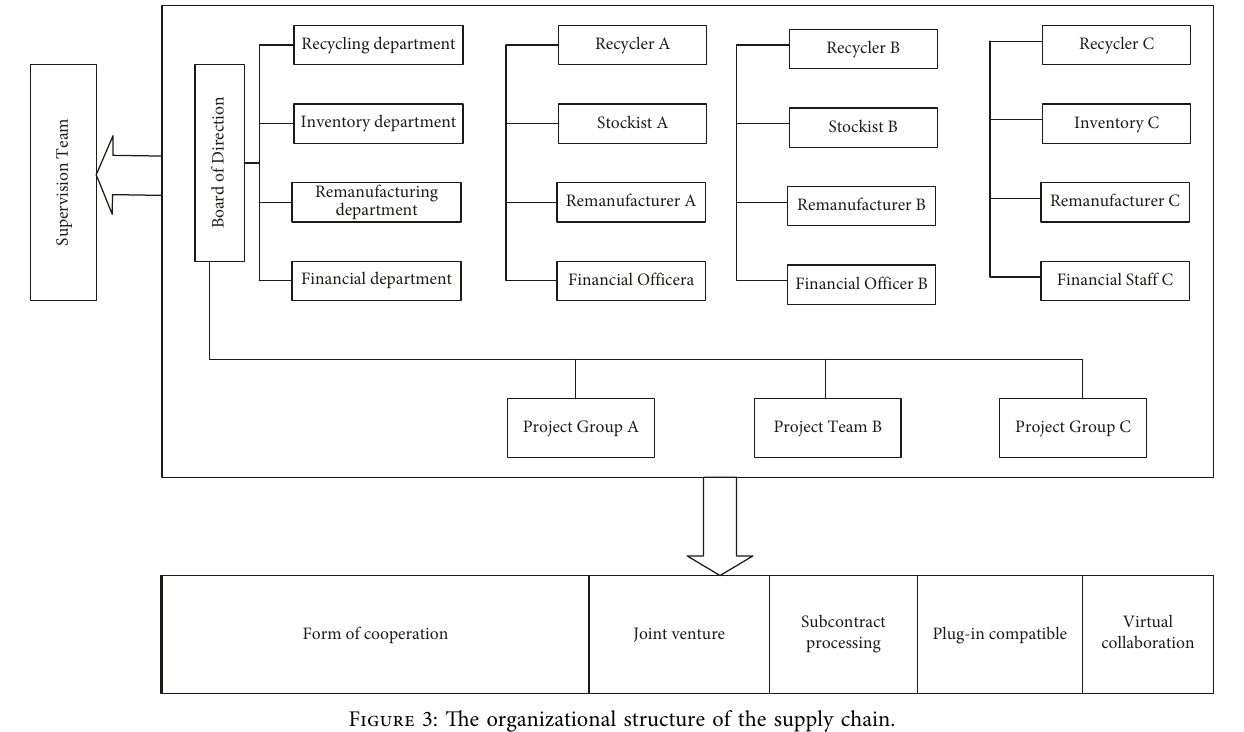
Figure 3: The organizational structure of the supply chain.